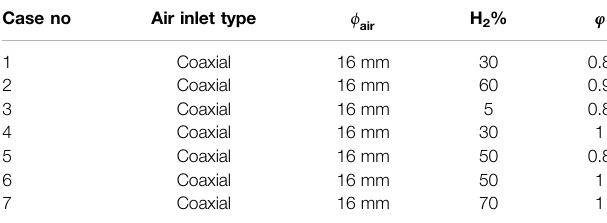
TABLE 1 | Summary of the operating conditions for the coaxial air injector